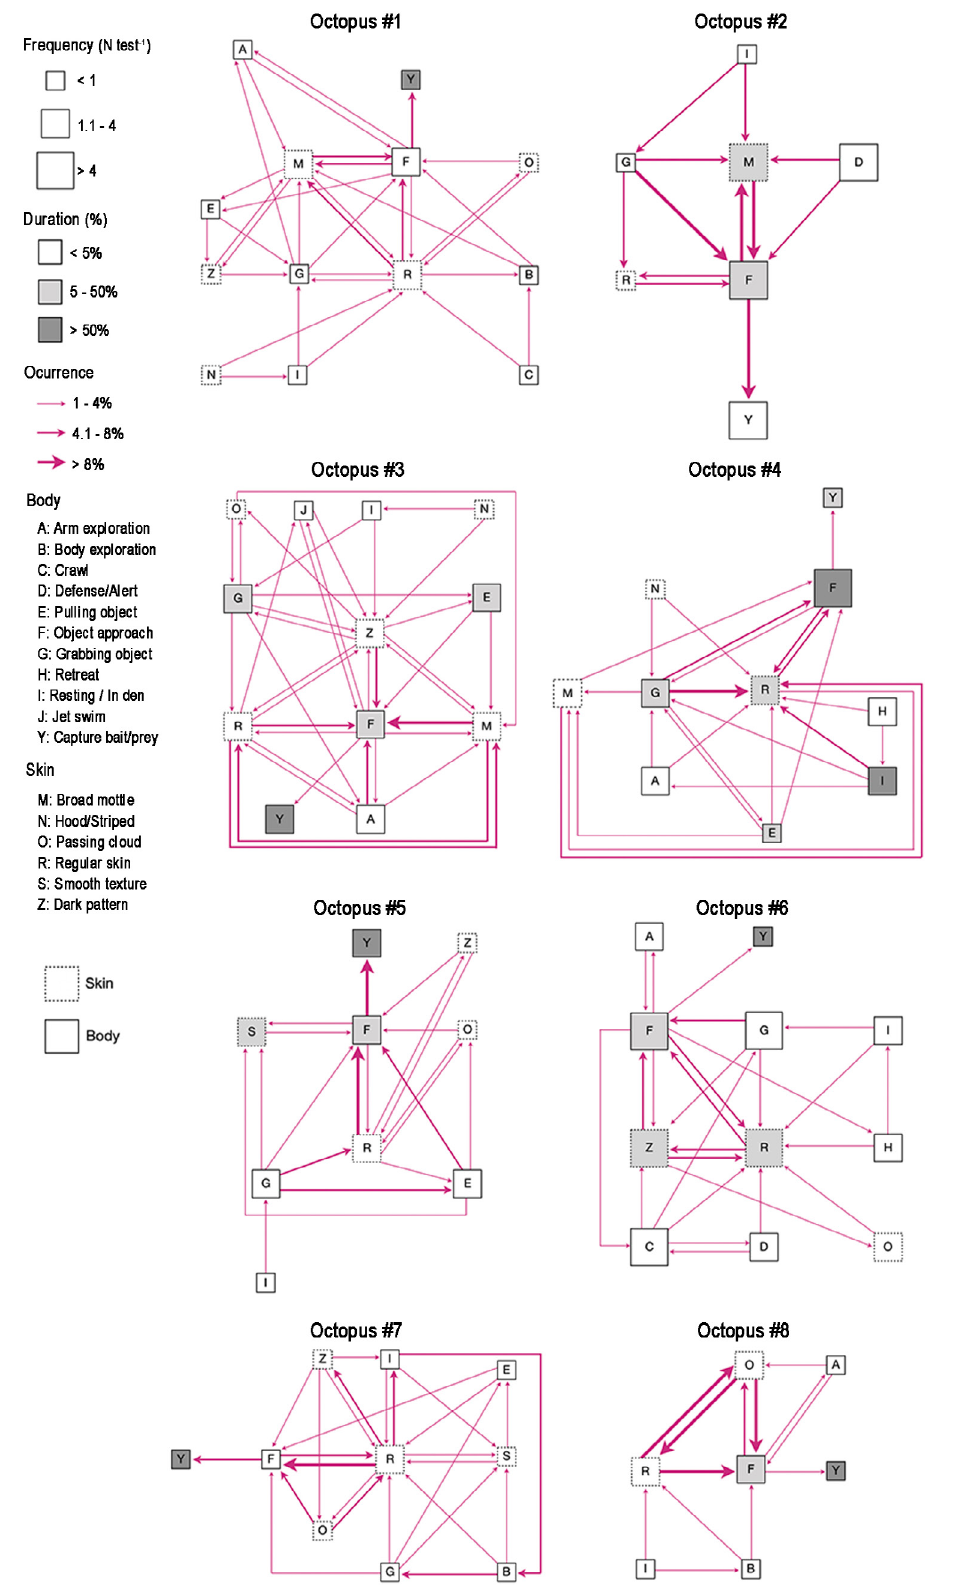
Fig. 3. – Kinematic diagrams of individual behaviours and body patterns of O. vulgaris observed during the experiment. The size and colours of bounding boxes around the behaviours is proportional to the relative frequency and duration of a particular behavioural pattern, respectively. Paired behaviour sequences are depicted as arrows. The magnitude of the occurrence of each paired sequence is shown by the arrow size. Transitions that occurred less than 1% (<0.01) of the time during an interaction were excluded. The continuous line squares show the body posture and movements, whereas the discontinuous line squares show the skin